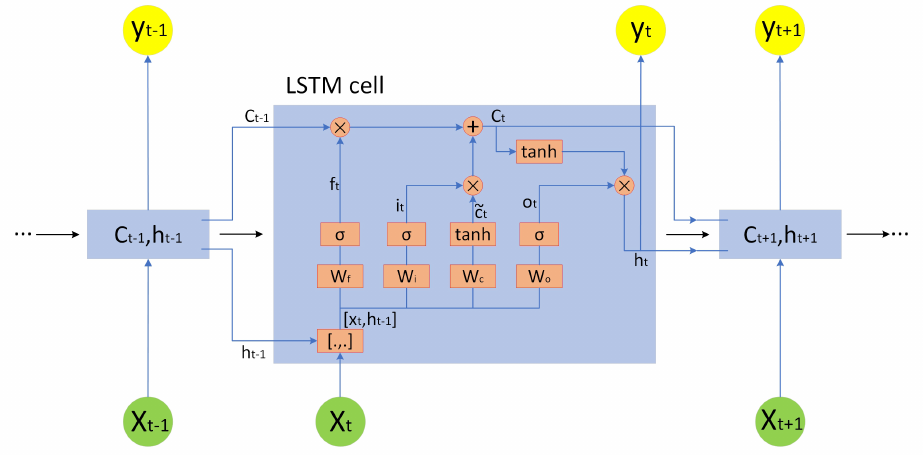
Figure 4. The LSTM neural network’s output is a combination of the outputs of each